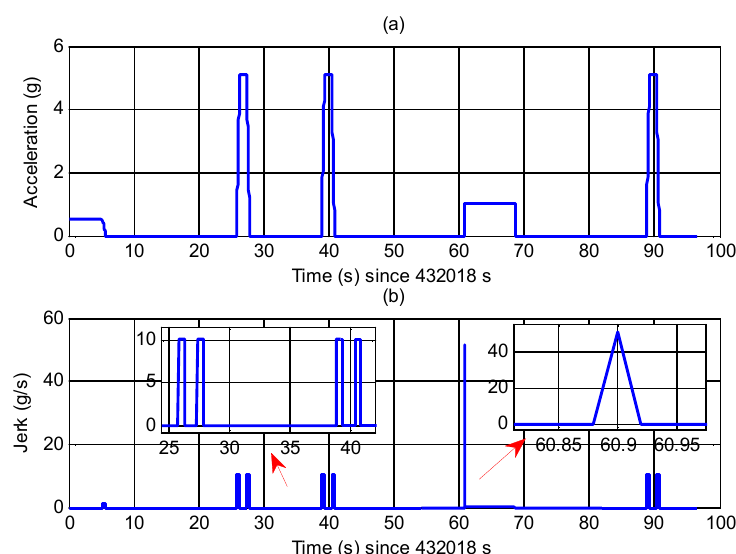
Figure 10. The flight acceleration and jerk of the dynamic test in polar areas: ( a ) acceleration; ( b ) jerk.